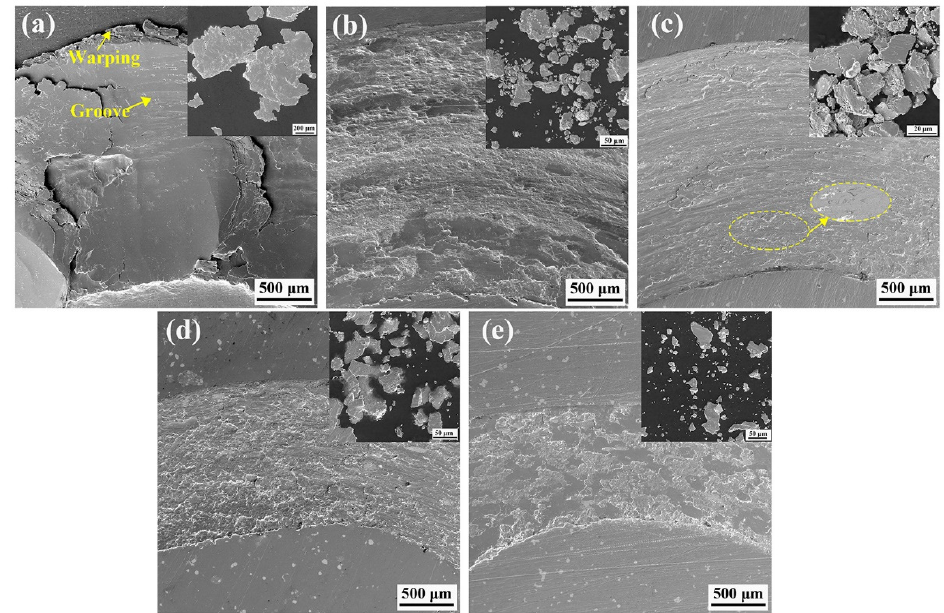
Figure 11. Wear scars and debris: ( a ) Cu–Cr–Zr substrate; ( b ) Ni–Cu coating; ( c ) Ni–Cu–10(W,Si) coating; ( d ) Ni–Cu–10(Mo,W,Si) coating; ( e ) Ni–Cu–15(Mo,W,Si) coating.